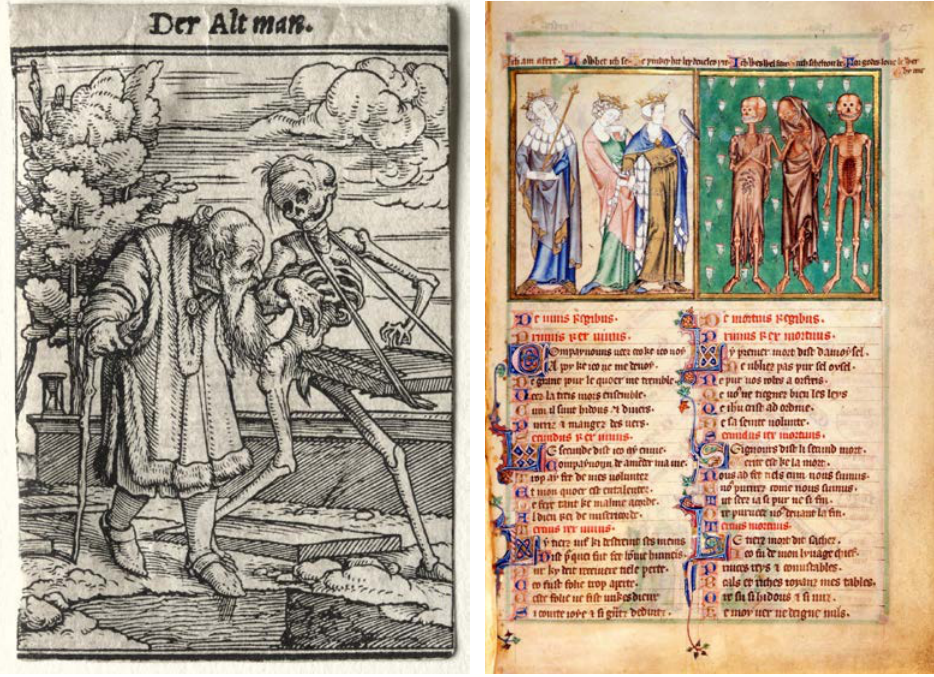
“The Three Living and the Three Dead,” The De Lisle Psalter, ca. 1308-40.